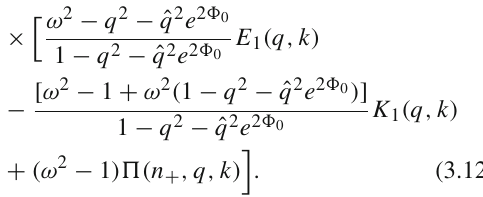
Fig. 5 The same complete generalised integrals has been plotted alongwith complete elliptic integrals under short string and long string limit with q = 0 . 8. Although, under short string limit both K 1 ( q , k ) ,